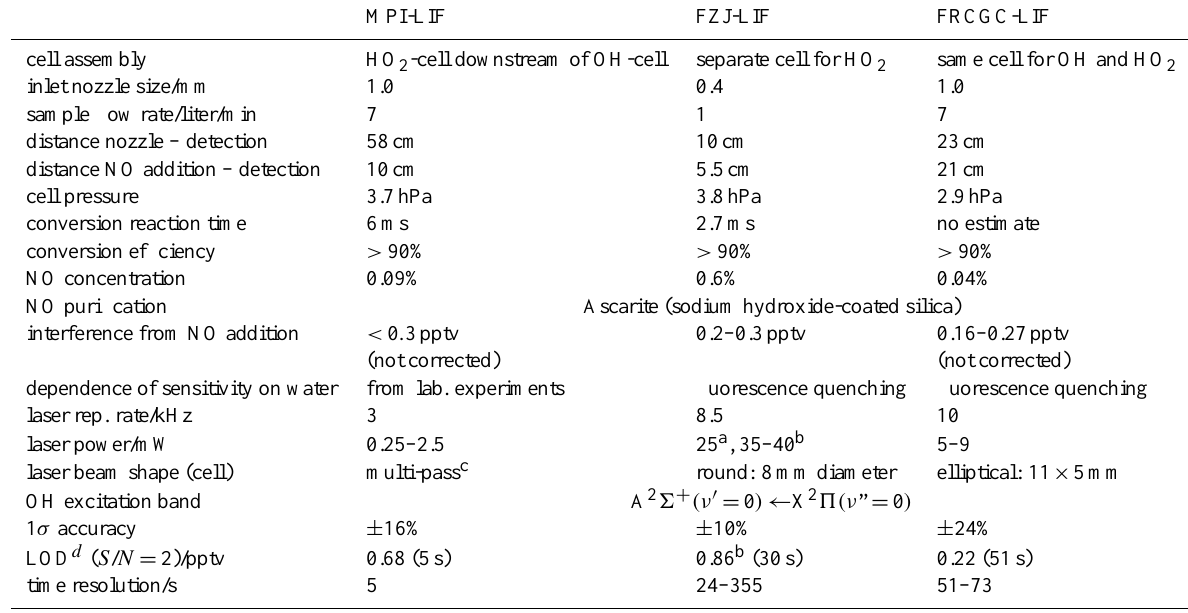
Table 1. Properties of the LIF instruments regarding the HO 2 detection.